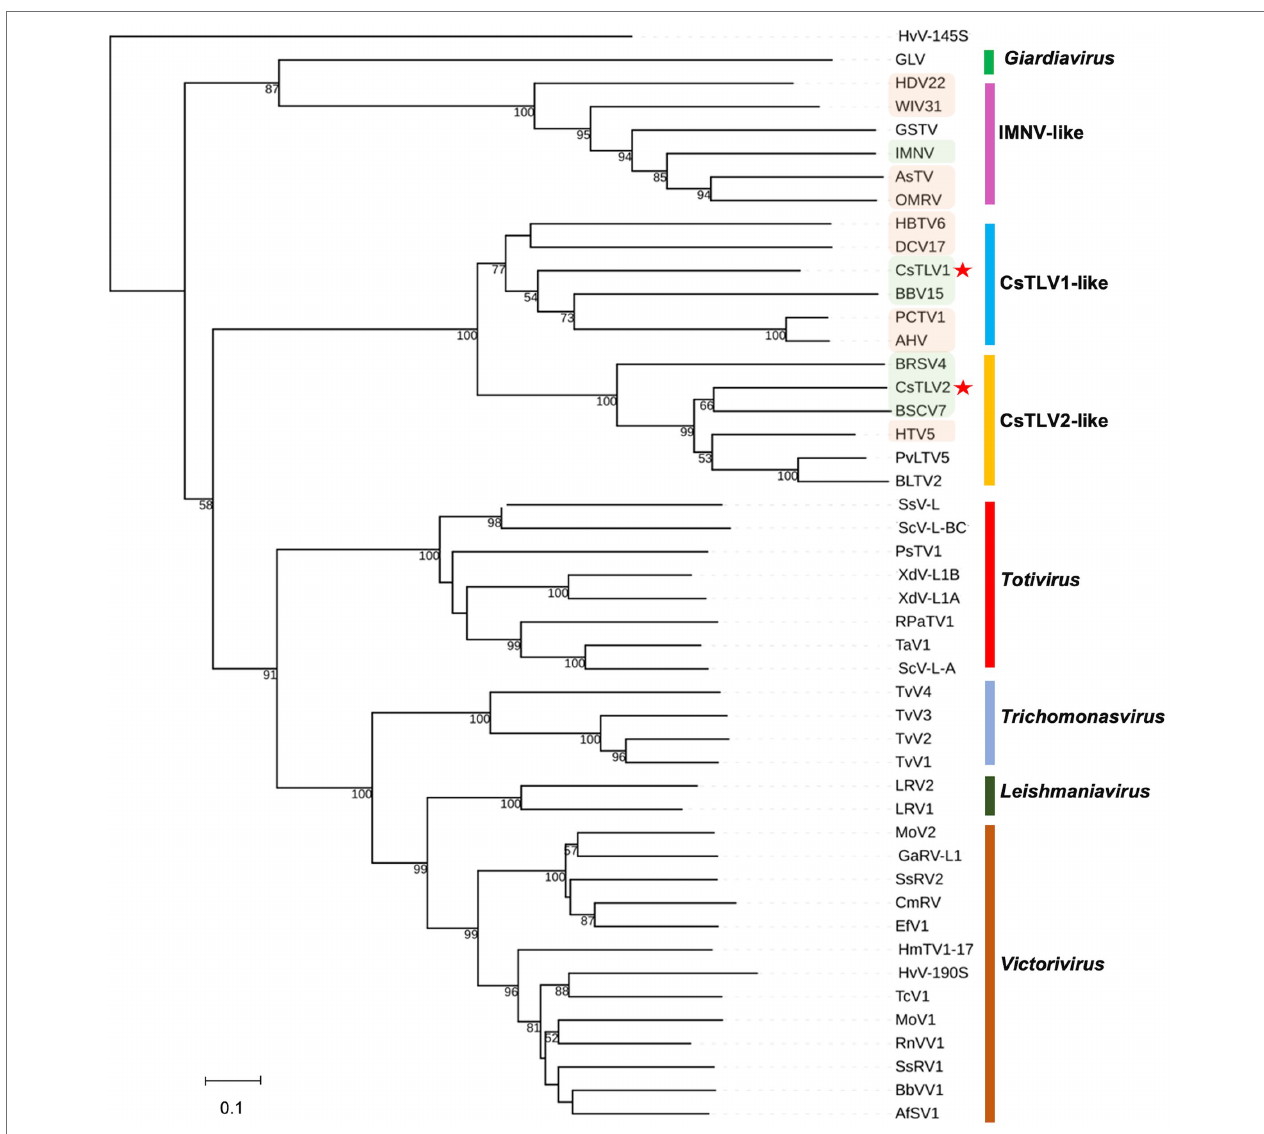
FIGURE 5 | Phylogenetic relationships between putative RdRp amino acids of CsTLV1 and CsTLV2 with other selected Totiviridae members. A phylogenetic tree was generated using the maximum likelihood (ML) method with 1,000 bootstrap replicates. CsTLV1 and CsTLV2 are highlighted with asterisks. Green shade indicates totiviruses identified in crustacean hosts and orange shade indicates totiviruses in other arthropod hosts. Virus notations are as in Supplementary Table 2